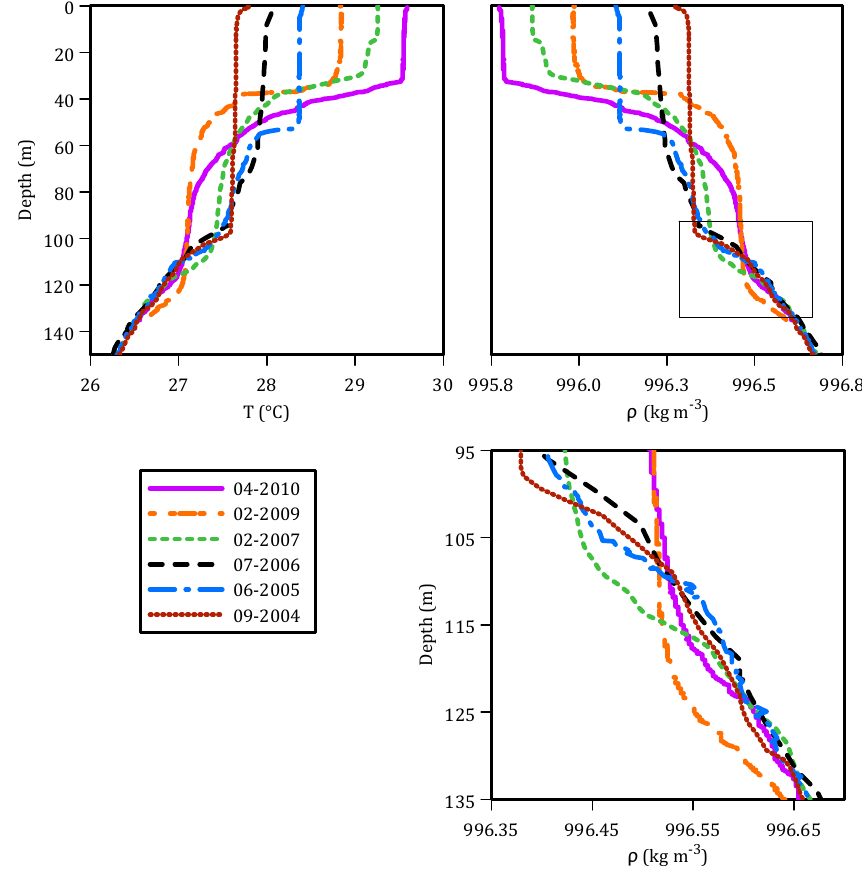
Fig. 2. Seasonal temperature and density in Lake Matano from 2004 to